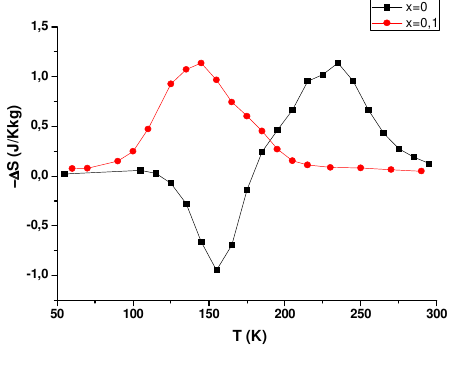
Fig. 6: Temperature dependence of magnetic entropy change for La 0.5 Ca 0.5 MnO 3 and La 0.4 Eu 0.1 Ca 0.5 MnO 3 samples under a magnetic applied field of